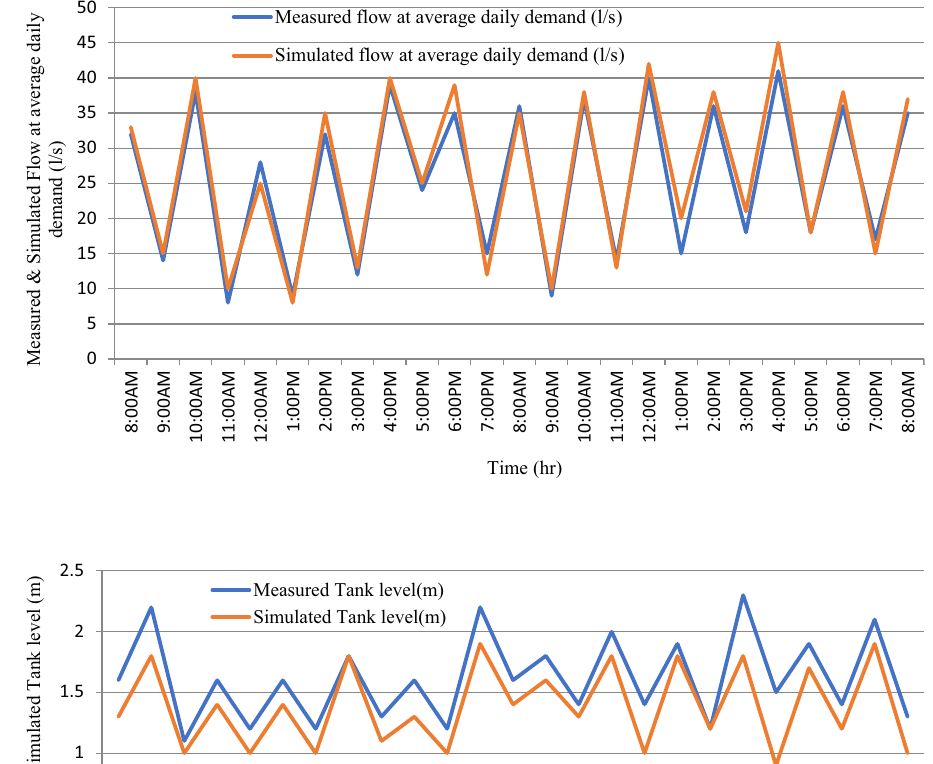
Fig. 9 Validation of Tank level during average daily